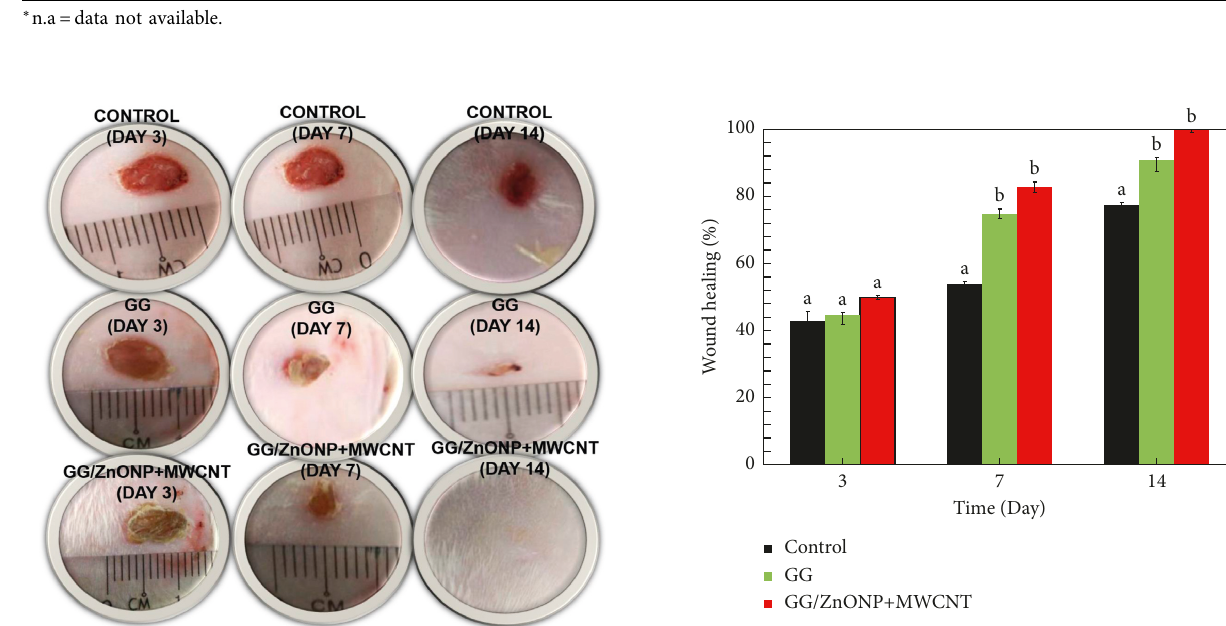
Figure 9: Wound healing percentage of the untreated wound (control) and treated with pure GG and GG/ZnONP+ MWCNT bionanocomposite films at 3 rd , 7 th , and 14 th days on Sprague Dawley rats. The presented data are expressed with mean n 6). Statistical analysis using one-way ANOVA followed by post (cid:28) hoc test shown by different letters (a, b) was statistically different ( P 0 . 05). ≤